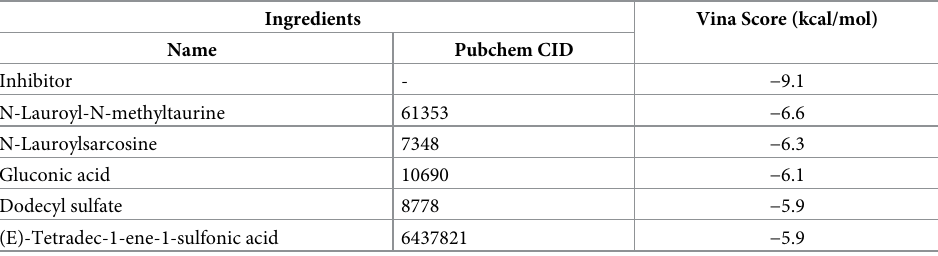
Table 3. Vina score of test ingredients for human ACE2. Ingredients